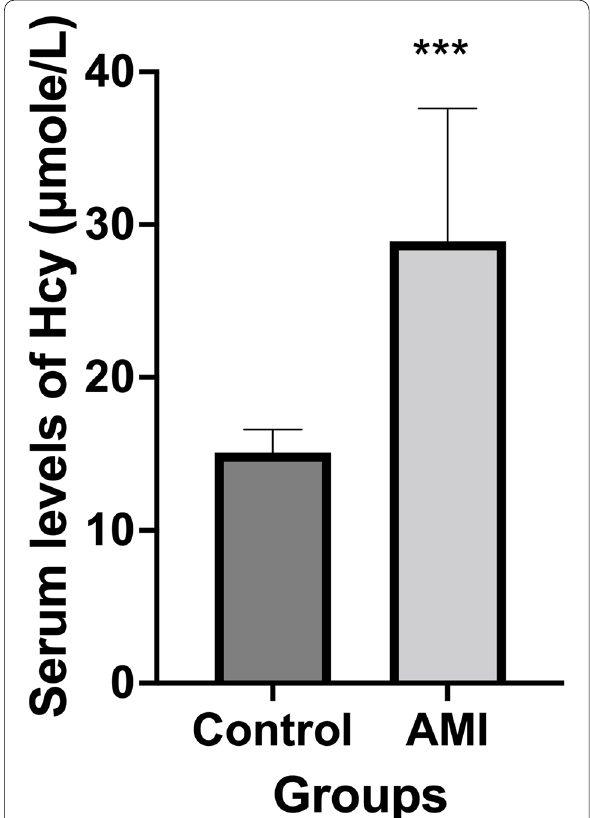
Fig. 2 The median serum Hcy levels in both study groups. ***Significant difference from the control group at P